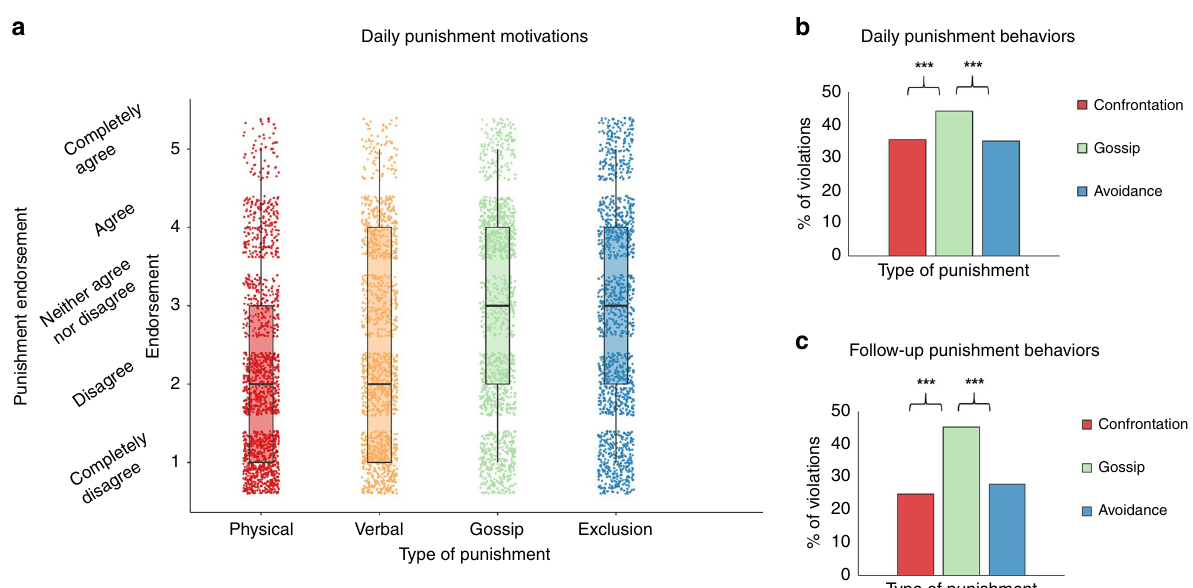
Fig. 1 Prevalence of different types of punishment responses in daily life. a Participants ’ endorsement of motivations to engage in various types of punishment, based on k = 1236 daily assessments. Four items assessed motivations to punish offenders via physical confrontation ( “ I felt like physically intervening to stop the offender. ” ), verbal confrontation ( “ I felt like yelling at or arguing with the offender. ” ), gossip ( “ I felt like sharing negative information about the offender to others. ” ), and exclusion ( “ I felt like excluding the offender from my social interactions in the future. ” ). Boxplot whiskers indicate the minimum (1) and maximum (5) values observed, box bounds indicate the fi rst quartile (equal to 1 for physical and verbal confrontation; equal to 2 for gossip and exclusion) and third quartile (equal to 3 for physical confrontation; equal to 4 for other types of punishment motivations), and horizontal lines indicate the median. Error bars represent standard deviations from the mean. b Percentages of violations in k = 1236 daily assessments and c in k = 879 follow-up assessments to which participants responded with each type of punishment behavior. Bars represent the percentage of assessments where participants responded “ Yes ” to items measuring confrontation ( “ I confronted the offender about his/her behavior. ” ; daily: 35.4%, follow-up: 24.9%), gossip ( “ I told someone else about this behavior when the offender was absent. ” ; daily: 44.1%, follow-up: 45.4%), and avoidance ( “ I avoided social contact with the offender. ” ; daily: 34.8%, follow-up: 27.9%). Results are based on Generalized Estimating Equations models with punishment type (confrontation, gossip, and social avoidance) as a factor and punishment behavior as the outcome (daily: Wald χ 2 (2) = 27.64, p < 0.001; follow-up: Wald χ 2 (2) = 145.81, p Source data are provided as a Source data fi